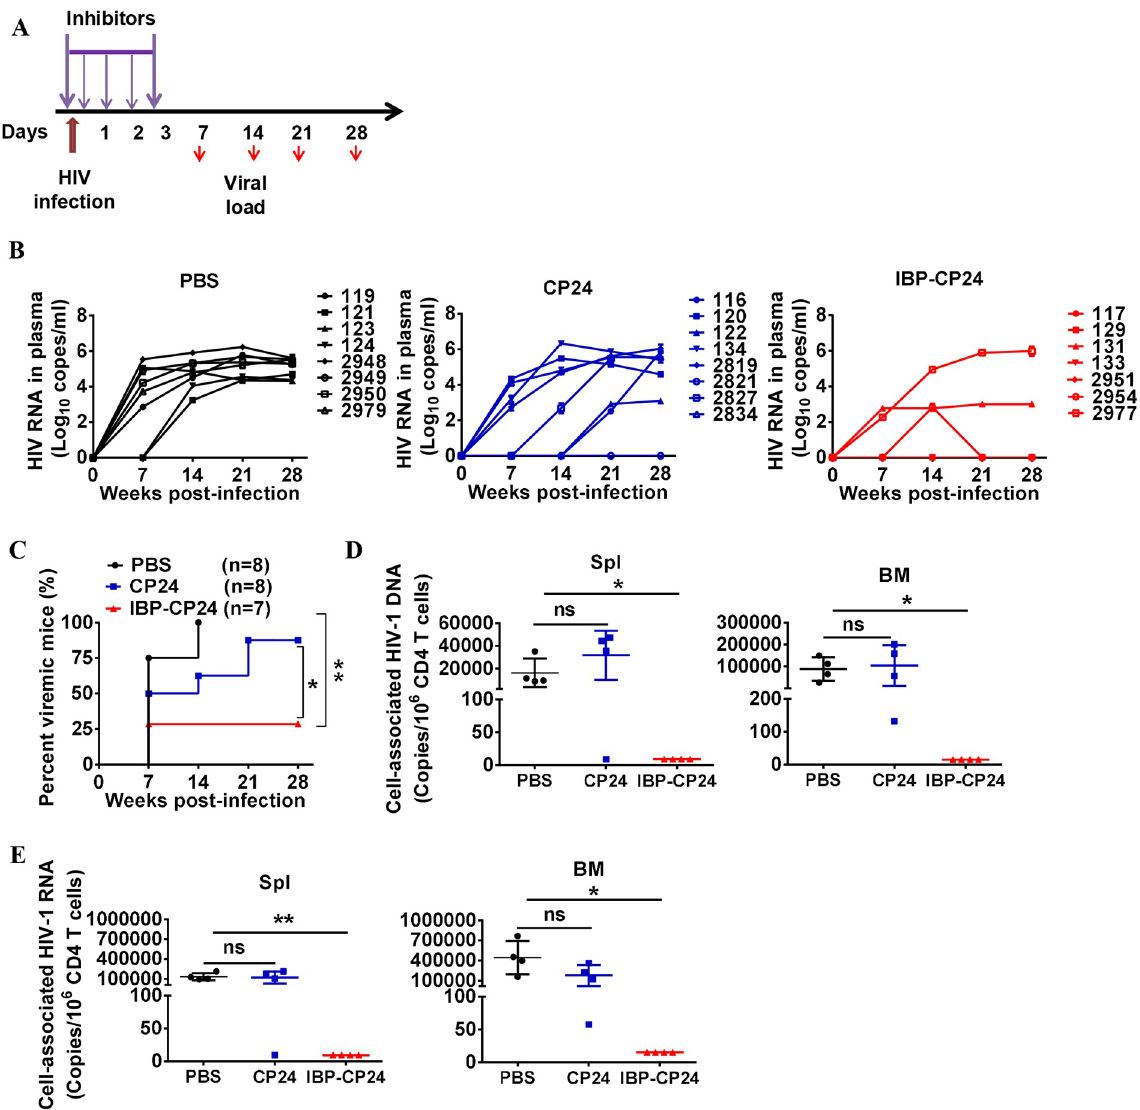
Fig 5. In vivo evaluation of the prophylactic activity of CP24 and IBP-CP24 in humanized mice. (A) Schematic diagram of the prophylactic experimental design. Humanized mice were challenged with HIV-1 JRCSF at 2 h post-treatment with PBS, CP24 and IBP-CP24. Mice were then injected with PBS, CP24 and IBP-CP24 peptides once at 6 h post-infection and then once every day for 3 consecutive days. (B) Plasma HIV-1 RNA levels were monitored at indicated time points in mice treated with PBS, CP24 or IBP-CP24. Shown are combined viremic data of two independent experiments. Each line represents a single mouse. (C) Summary of prophylactic protection of CP24 and IBP-CP24. Shown are summarized data of 2 independent experiments. PBS, n = 8; CP24, n = 8; IBP-CP24, n = 7. (D and E) Cell-associated HIV-1 DNA (D) and RNA (E) in human cells from mouse spleen and bone marrow were quantified by real-time PCR. All mice were terminated at day 28 post-infection. Shown are representative data of one independent experiment. Data were presented as mean ± SD. Log-rank test (C) or unpaired, 2-tailed t test (D and E) was performed. � P < 0.05, �� P <